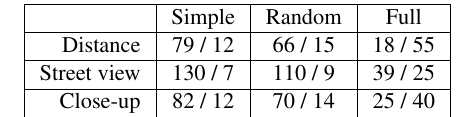
Figure 11: This table contains some time statistics (frames per second / ms per frame) of our system with respect to the different views of Figure 10. In the simple version, we just apply several subdivisions to each facade utilizing a static set of textures as atomic elements (cf. Figure 13.a). For the random version, we additionally apply randomization operators to get a wide variety of combined walls and windows (cf. Figure 13.b). In the full version, we take advantage of all presented concepts including randomization, layers, masking and intrusion (cf. Figure 10).